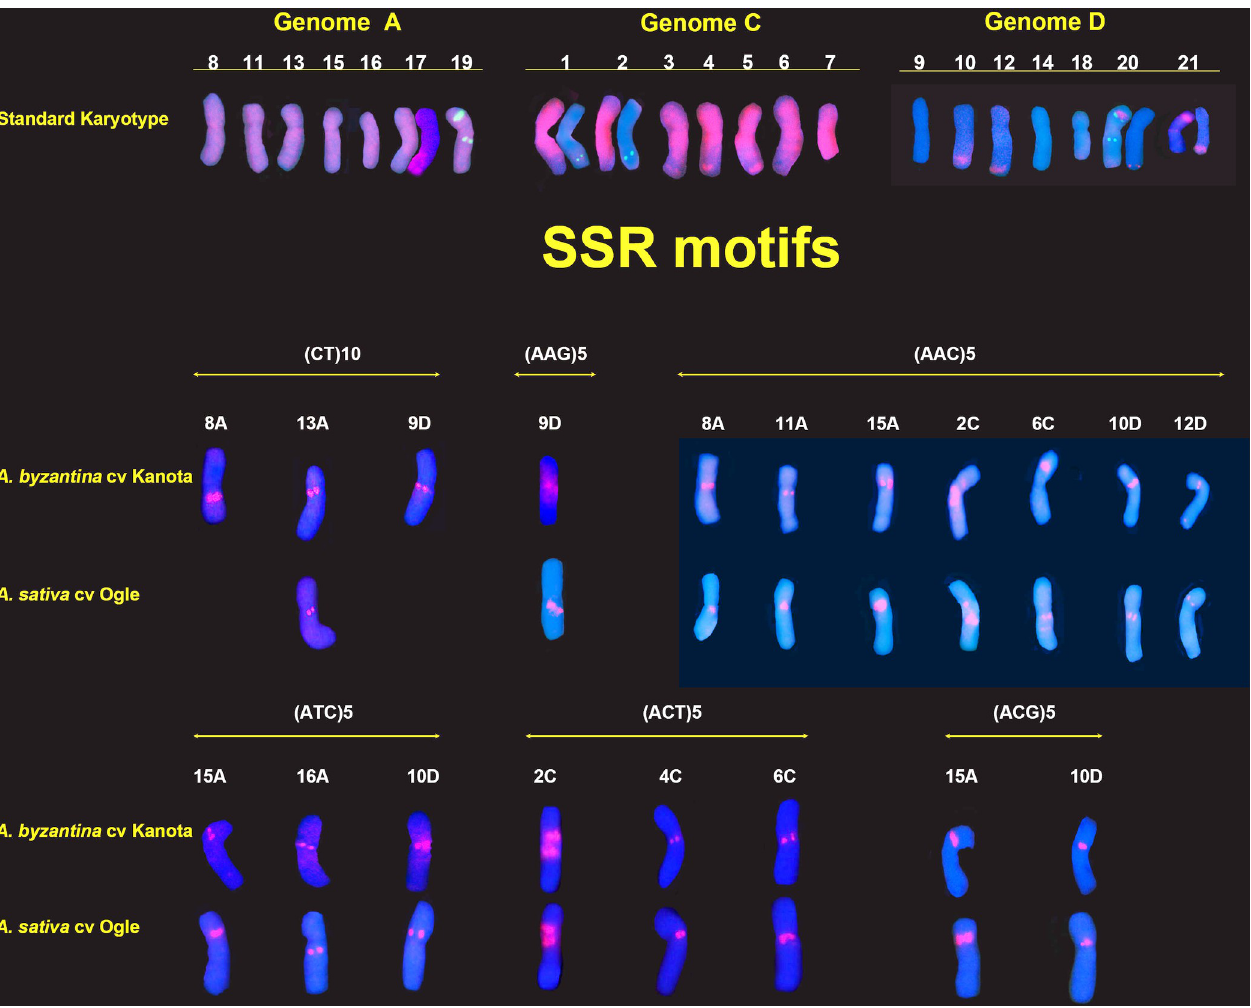
Fig 5. Karyotypes of hexaploid species showing a single chromosome of each homologous pair from the metaphases of cells in Fig 4. Standard karyotype is based on the FISH distribution patterns of Am1, 120a, 45S and 5S. Chromosome nomenclature is based on that Sanz et al. [18]. Standard karyotype: Am1 (red), 45S (green, 19A, 20A, 21D) and 5S (green, 1C, 2C, 19D, 20D). Panels of SSR motifs show chromosomes with specific SSR signals in